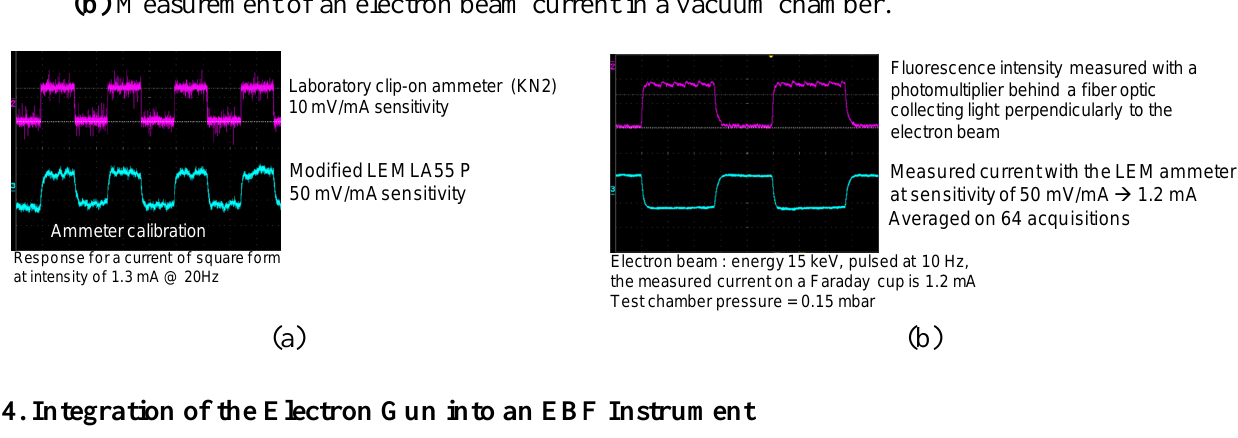
Figure 4. Electron beam current measurements with the amplified LEM LA55P ammeter. (a) Calibration of the beam current with a standard laboratory ammeter (KN2). (b) Measurement of an electron beam current in a vacuum